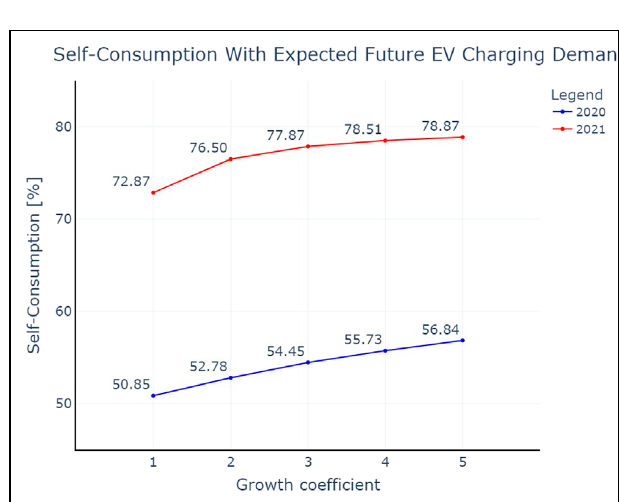
FIGURE 11 | Variation of Self-consumption with increasing EV charging